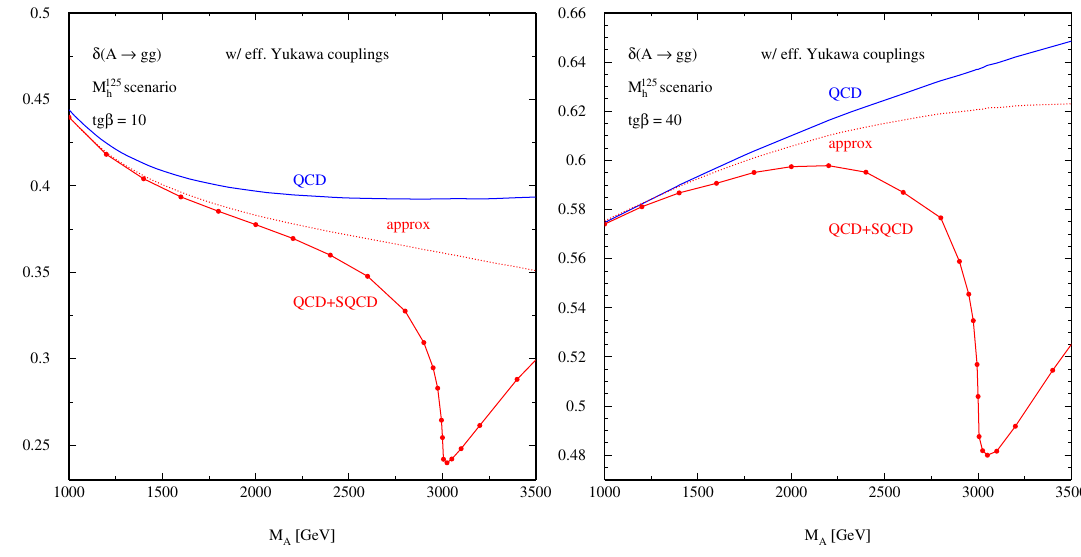
Figure 11 . Relative radiative corrections, defined as Γ = Γ LO (1 + δ ) , to the gluonic pseudoscalar decay width as a function of the pseudoscalar mass M A for tg β = 10 (left) and tg β = 40 (right) at NLO QCD and including the genuine SUSY-QCD corrections involving effective Yukawa couplings. The renormalization scale has been chosen as µ R = M A .